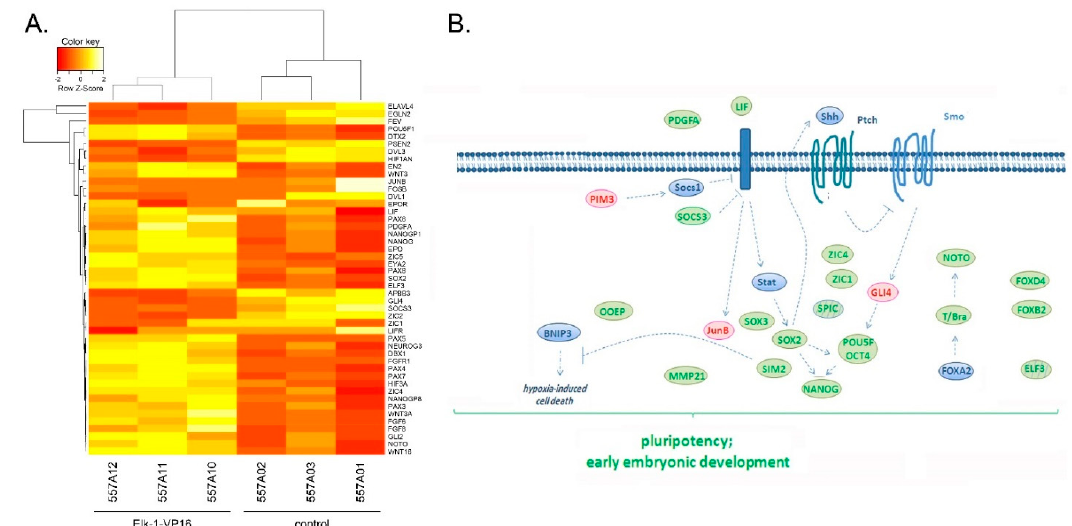
Figure 1. ( A ) Heatmap of a subset of genes regulated by Elk-1-VP16 showing increased (green) or decreased (red) expression in Elk1-VP16 overexpressing SH-SY5Y neuroblastoma cells; 557A10, 557A11, 557A12 correspond to SH-SY5Y cells transfected with Elk-1-VP16 expression plasmid, 557A01,557A02,557A03 control SH-SY5Y cells transfected with empty plasmid; color key shows up- and downregulation levels. ( B ) Schematic representation of the relation between selected genes in pluripotency and early embryonic development pathways that were found to be regulated by Elk-1-VP16 in microarray